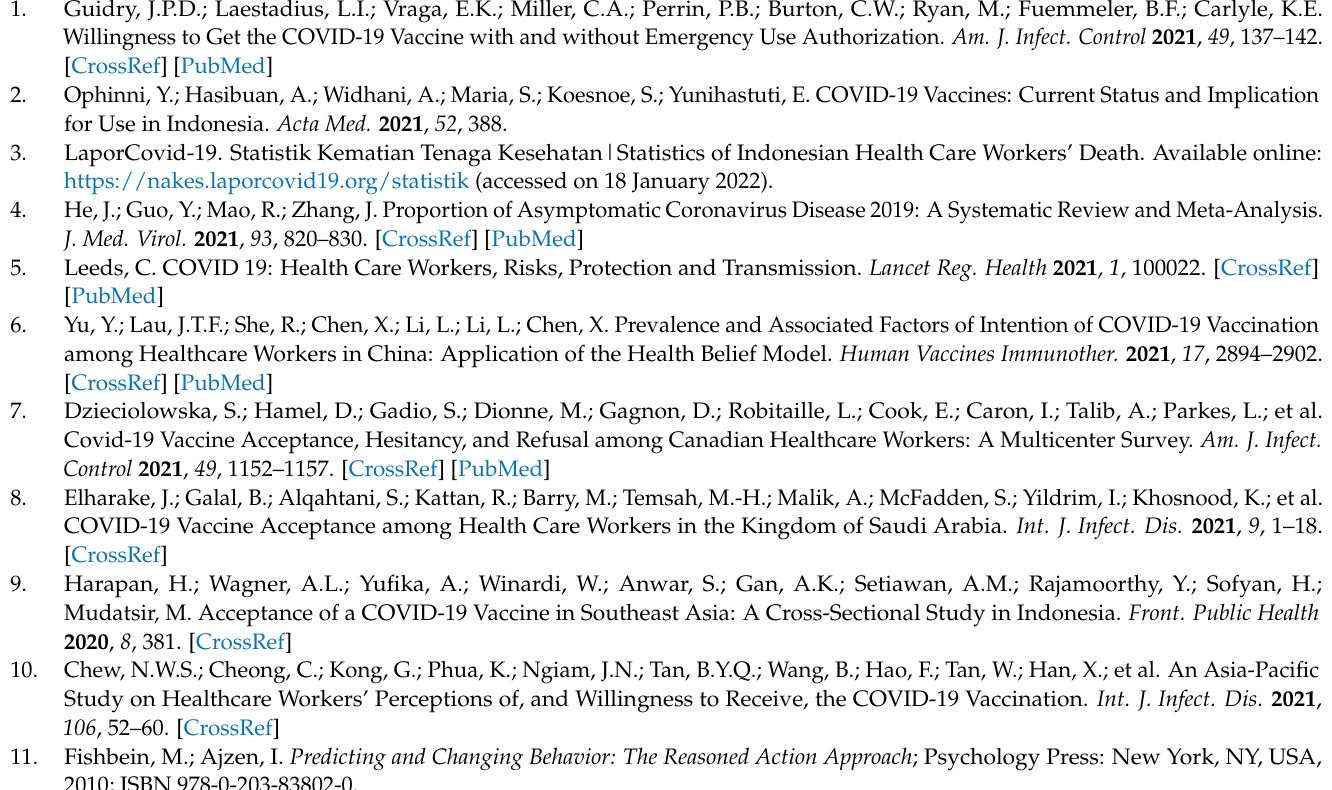
Table S1. Final regression model with additional data. Table S2. List of